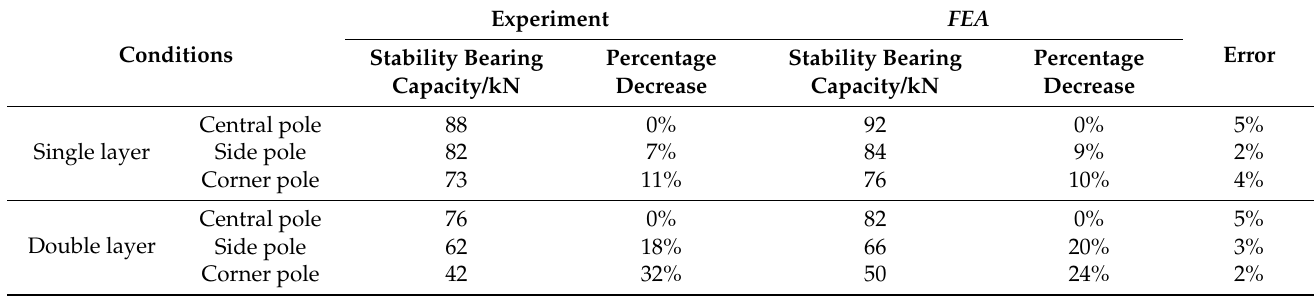
Table 6. Comparative analysis of the stability bearing capacity of the vertical